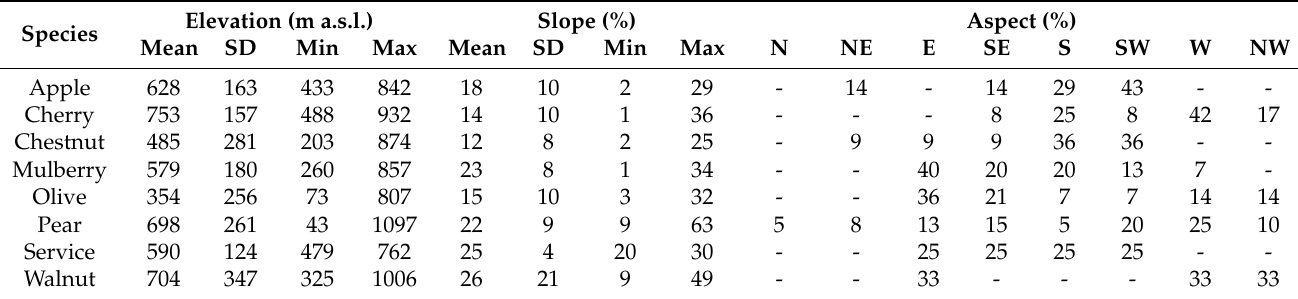
Table 1. Topography features of fruit tree locations summarized by tree species. Elevation is expressed in meters above sea level (m a.s.l.). Slope is expressed in percentages. Aspect is divided into 8 cardinal directions and expressed as % of trees per direction.